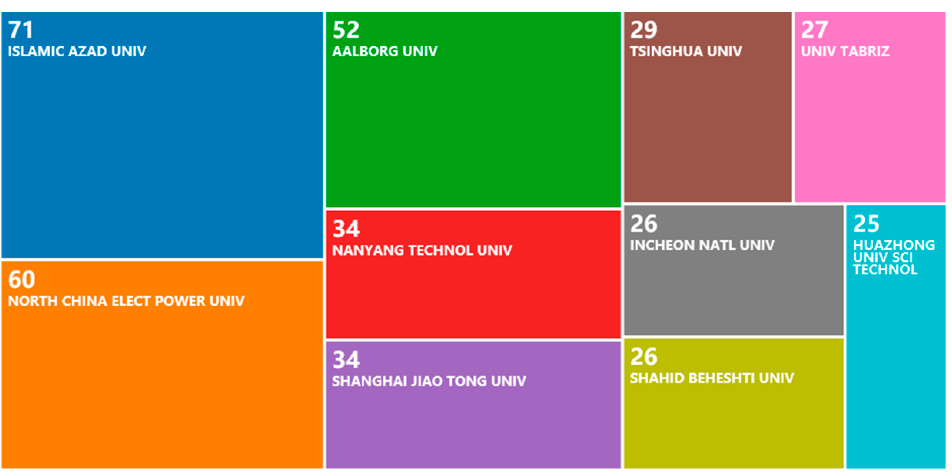
Figure 9. Dendrogram of publishers.